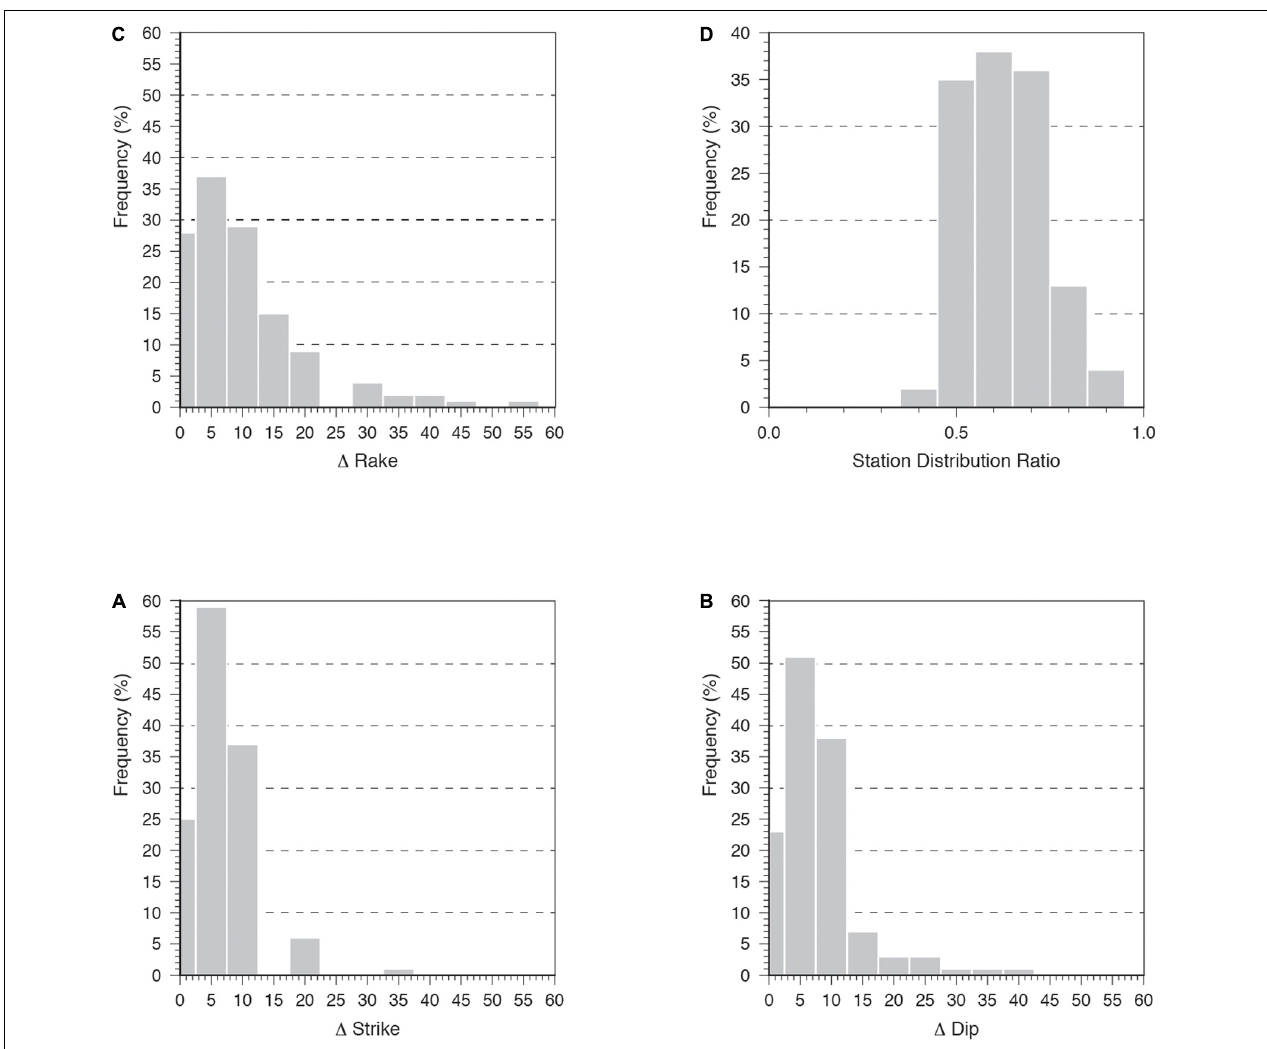
FIGURE 3 | Histograms of the uncertainties distributions of strike (A) , dip (B) , and rake (C) of the presented focal solutions with STDR (stations distribution ratio) (D) .